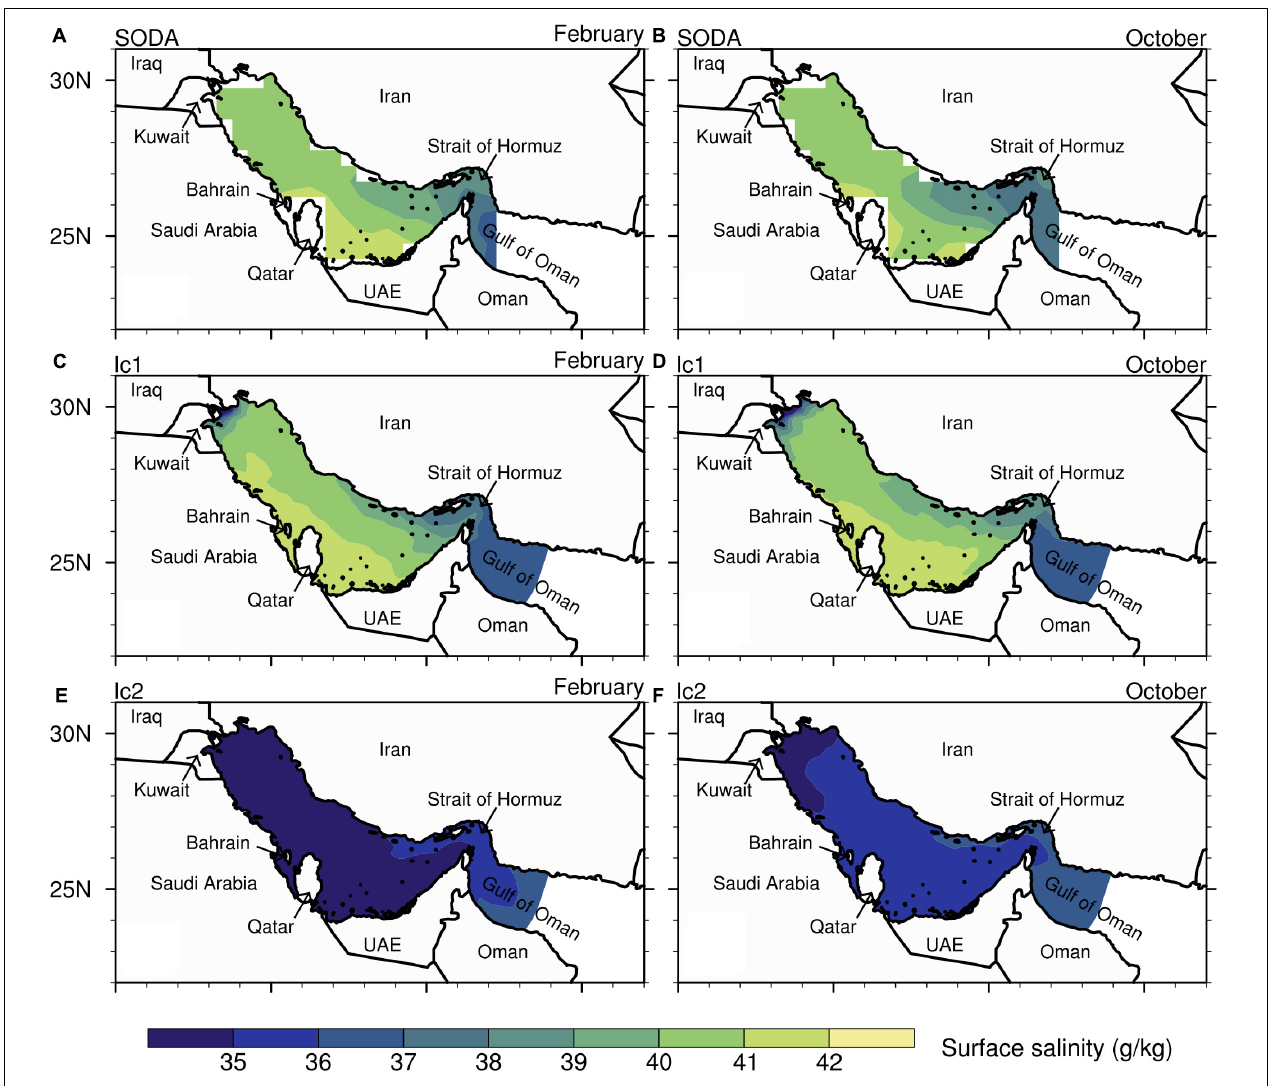
FIGURE 3 | Simulated climatological (1981–1990) sea-surface salinity (SSS) in February and October compared to reanalysis SODA SSS. (A,B) SODA. (C,D) Ic1experiment. (E,F) Ic2